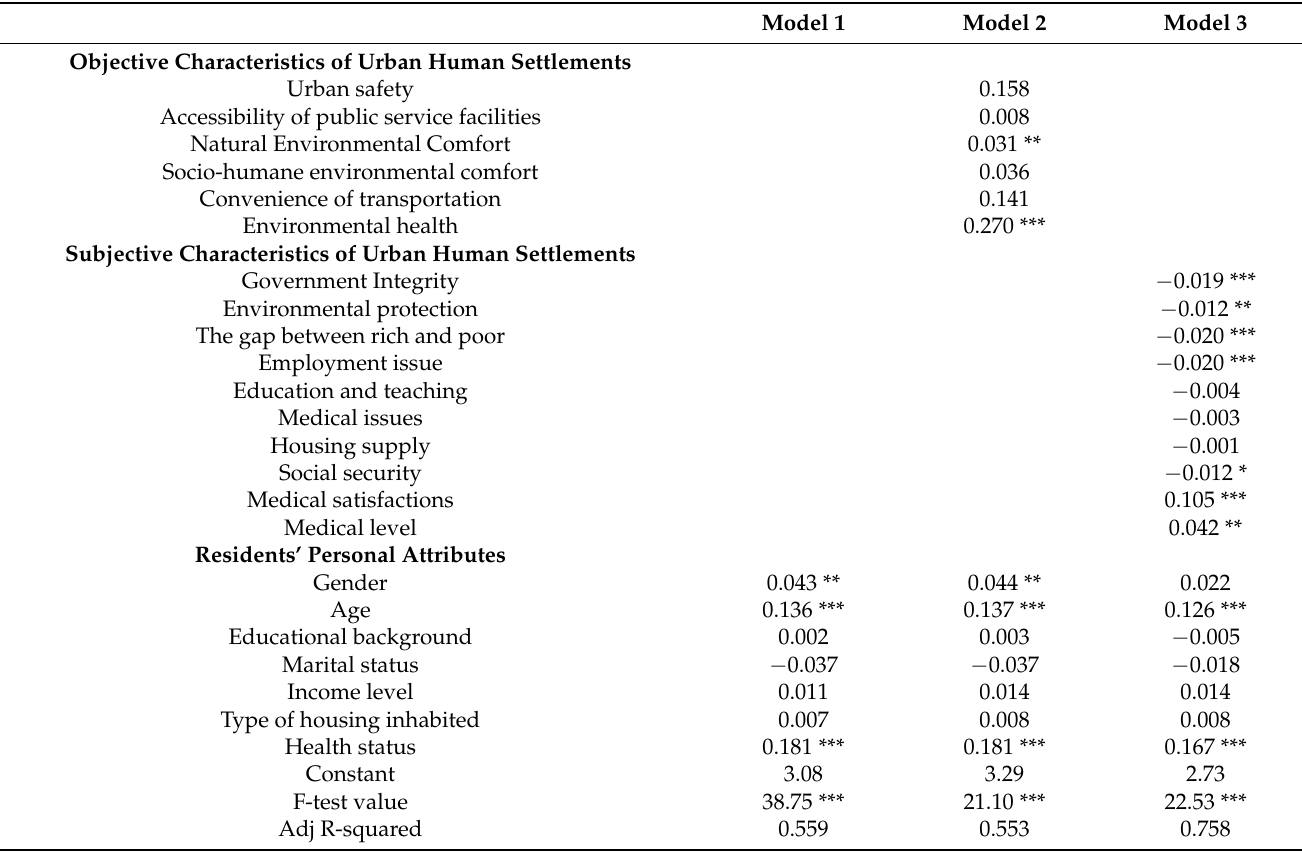
Table 4. Multilevel linear regression estimation